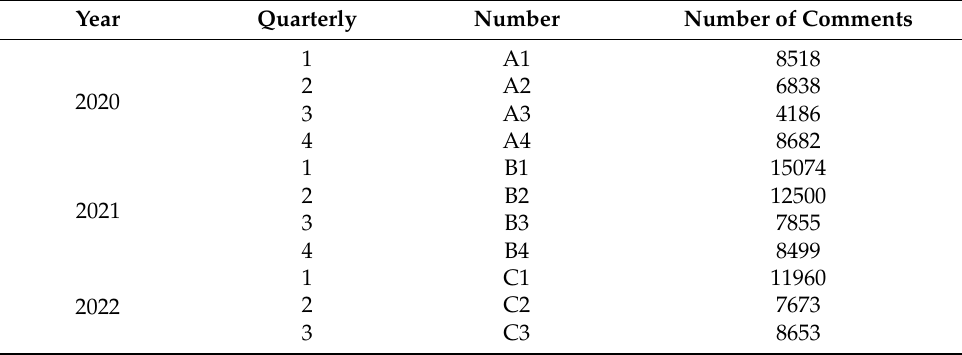
Table 1. Total number of Weibo tweets, January 2019 to September